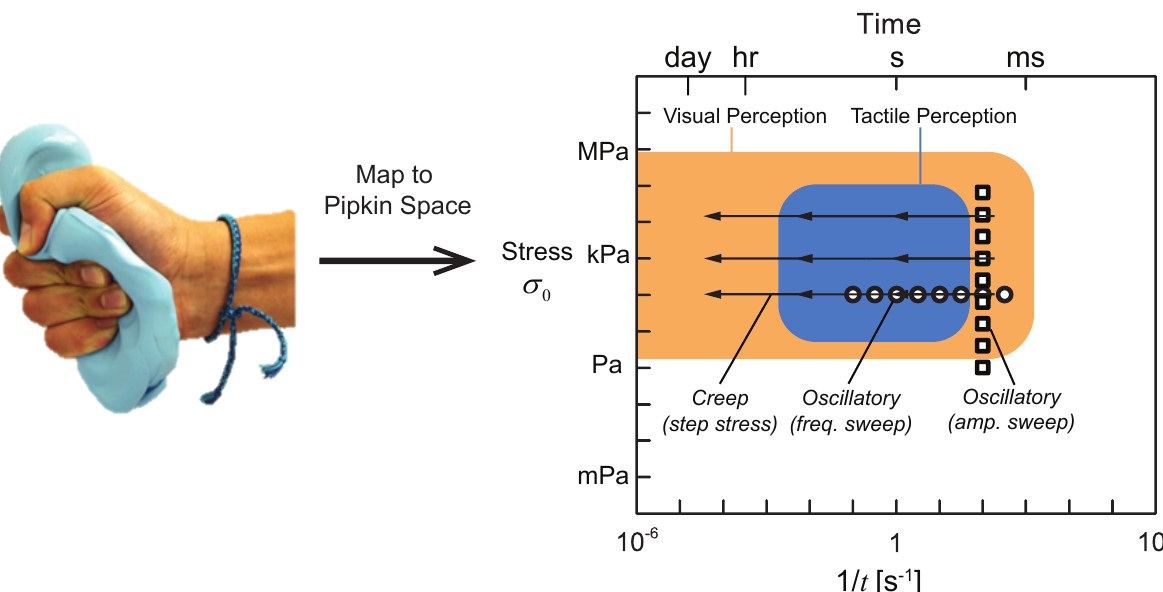
Figure 5: Pipkin diagram [73] adapted to map perception from Table 1 using stress for the amplitude (rather than strain or strain-rate). Stress-amplitude σ 0 is a more natural mapping for user-experience. Regions relevant to human perception guide rheological characteriza- tion, shown as locations or trajectories through the Pipkin space.